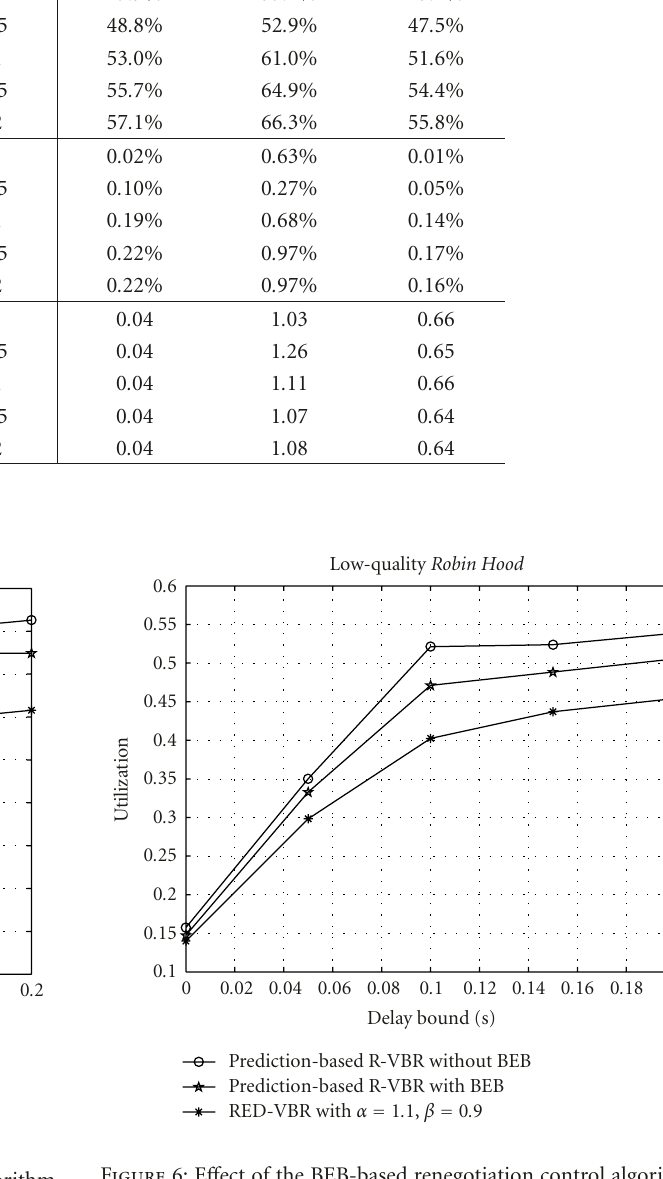
Figure 5: E ff ect of the BEB-based renegotiation control algorithm for Mr. Bean . (The performance of RED-VBR is also plotted to il- lustrate the minimal impact of the link utilization with BEB-based approach.)